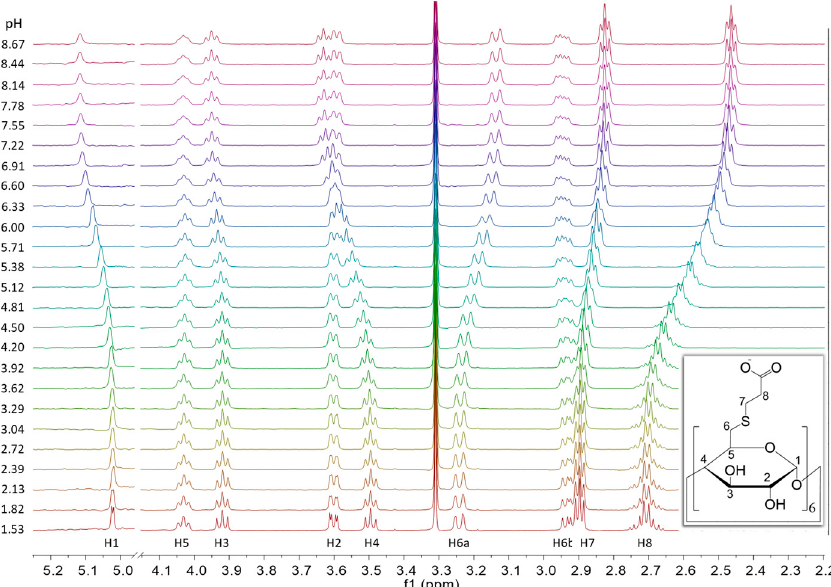
Figure 2. pH-dependent series of 1 H NMR spectra of Su α -CD, with structure and atom numbering of the compound and assignment of the NMR signals (600 MHz, 298 K, H 2 O:D 2 O = 9:1).